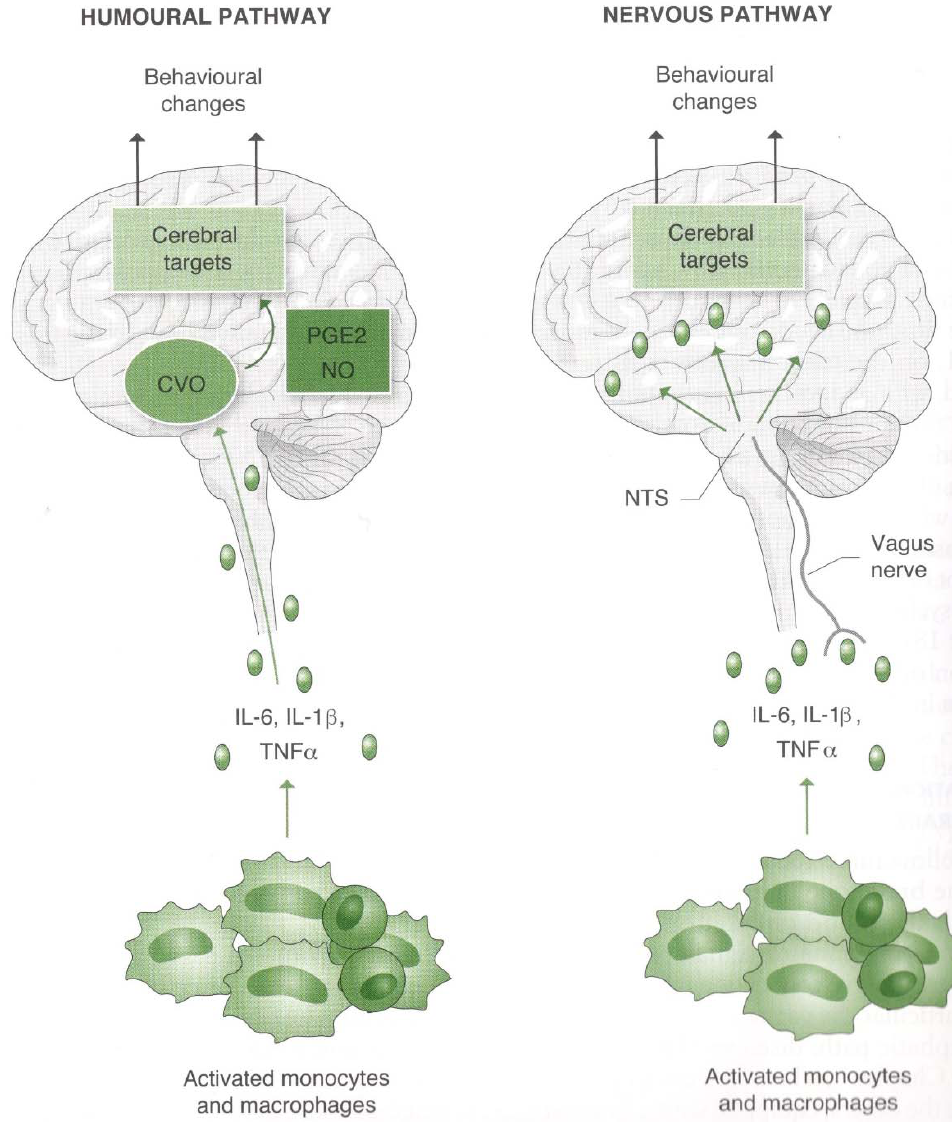
Figure 3. The two communication pathways from the bottom to the top: from the immune system to the brain. On the left is the humoral pathway, which, through blood circulation, carries cytokines directly to the circumventricular organs of the brain (around the ventricles) without a blood–brain barrier. Where there is a barrier, the cytokines can pass through using specific transport systems (not shown) or even by stimulating the production of other substances, such as nitric oxide (NO) and prostaglandins (PG). On the right is the nervous pathway, which—particularly through the vagus nerve, which has cytokine receptors—carries immune signals first into the nucleus tractus solitarii (NTS) and from there to the other brain structures, in particular, to the limbic system (hypothalamus, hippocampus, and amygdala). Reprinted with permission from Ref. [2]. 2020, Edra.